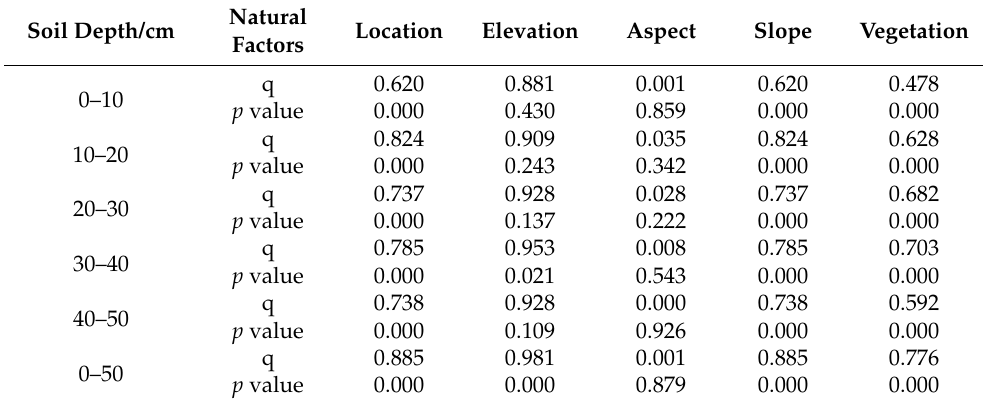
Table 5. q values of evaluation